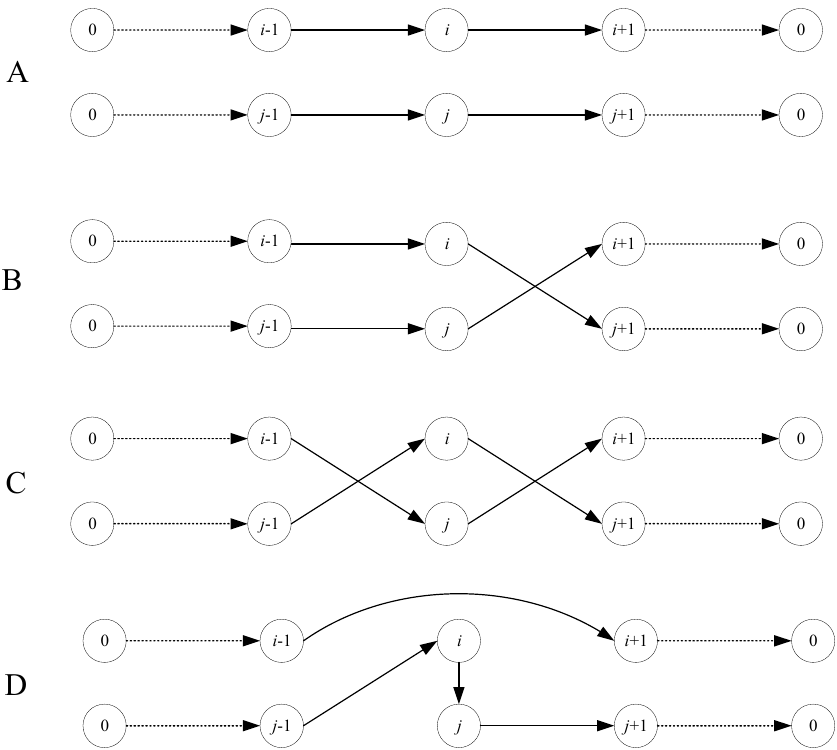
Figure 2. A is the initial solution, B is the result after 2-opt*, C is the result after 2-exchange, D is the result after 2-relocate.